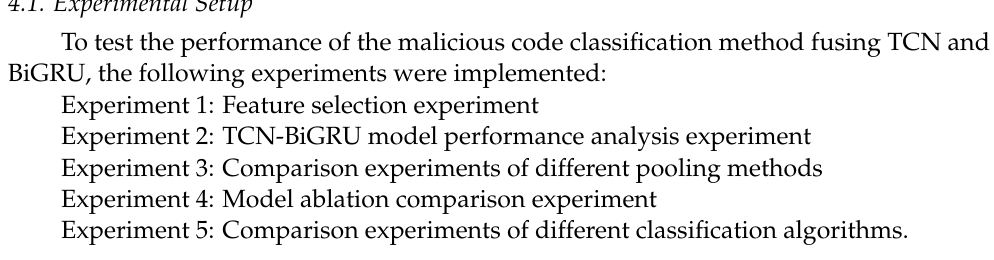
Figure 11. Datacon sample. To fully evaluate our method, experiments were conducted on two different datasets according to different methods to fully validate the model. The first method used 9 mali- cious families in Kaggle malicious samples labeled 1 – 9, and the dataset was noted as 9-